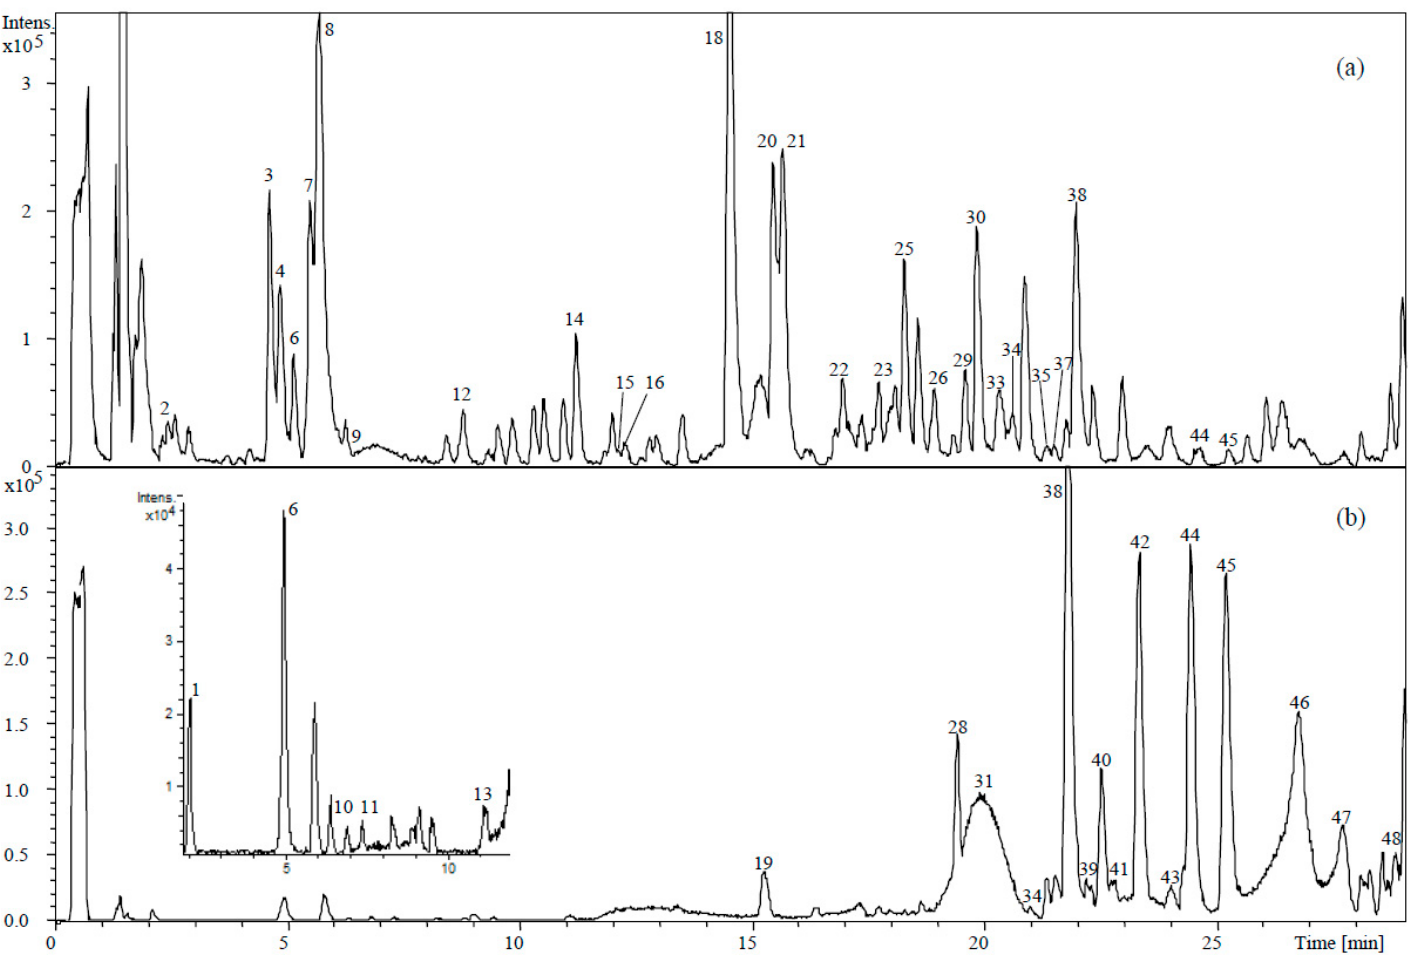
Figure 1. Base peak chromatogram (BPC) of ‘Arbosana’ phenolic compounds of olive fruits ( a ) and olive oil ( b ), using HPLC-DAD-TOF-MS. Proposed phenolic compounds were numbered by elution order (See Table 1 for peak numbers).